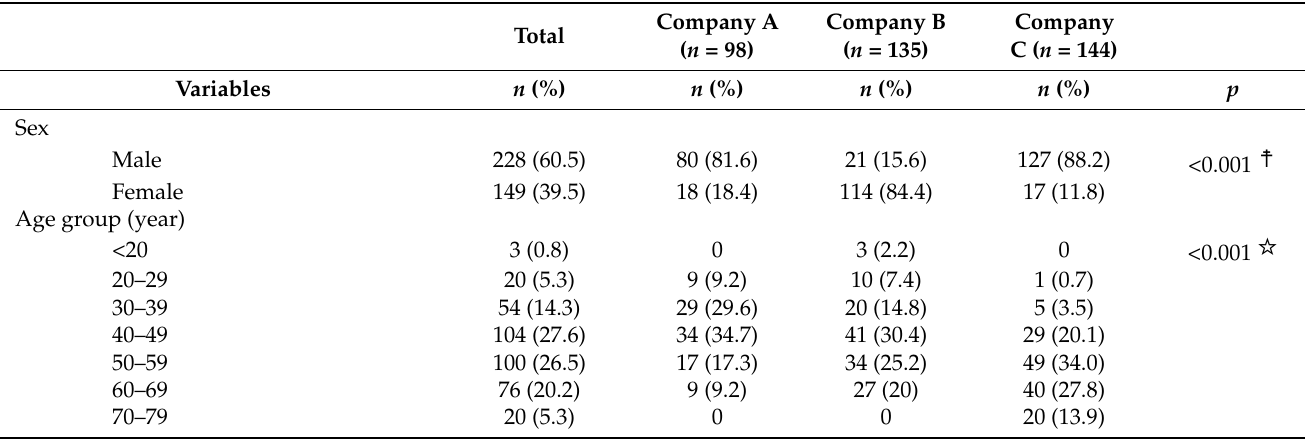
Table 1. Sociodemographic characteristics of the study participants of three companies ( n =